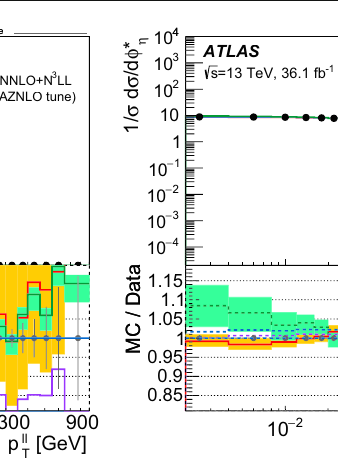
Fig. 5 Comparison of the normalized p (cid:3)(cid:3) (left) and φ ∗ η (right) distribu- with the Born level combined measurement. The uncertainties of the T measurementareshownasverticalbarsanduncertaintiesofthe Sherpa tions predicted by different computations: Pythia 8 with the AZ tune, Powheg + Pythia 8 with the AZNLO tune, Sherpa v2.2.1 and RadISH and RadISH predictions are indicated by the coloured bands